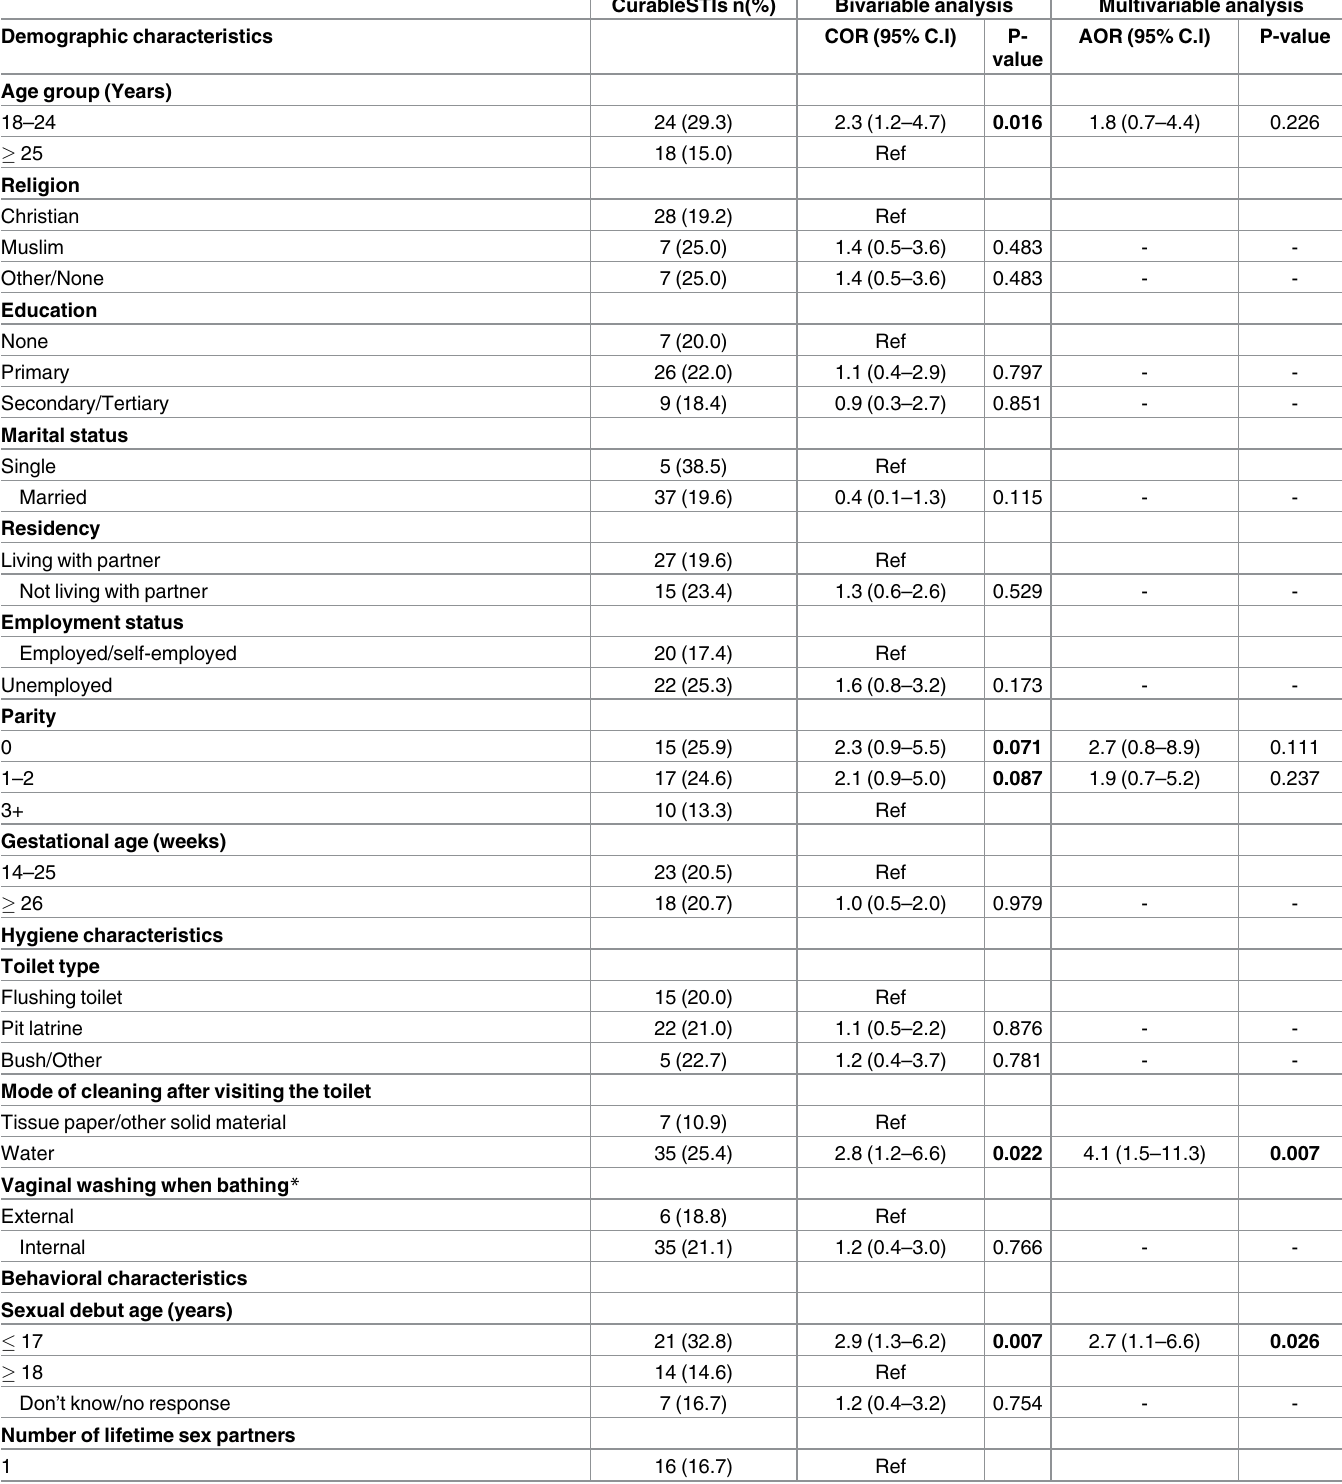
Table 2. Bivariable and multivariable analysis of socio-demographic, hygienic, behavioral, and clinical characteristics of pregnant women with curable sexually transmitted infections attending antenatal clinic at Kilifi County Hospital, July—September 2015 (n =